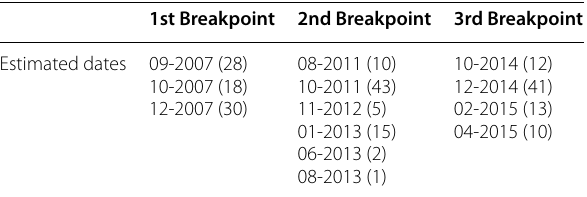
Values in brackets indicate the number of models in which a certain date has been identified as a breakpoint